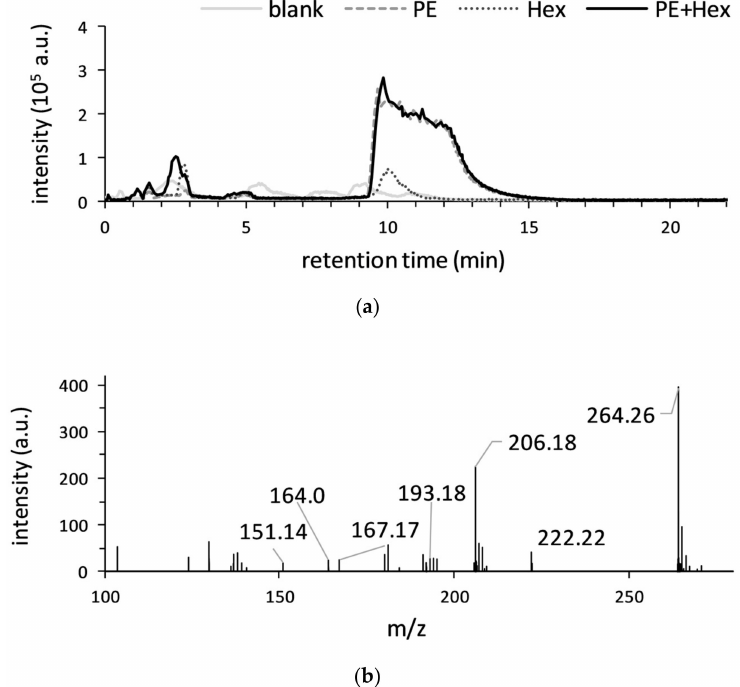
Figure 1. Tentative identification of a carbonyl-amine adduct derived from phosphatidylethanolamine (PE) (16:0 / 18:1) and hexanal. Overlaid base peak chromatograms ( m / z 50–2500) obtained from LC-ESI-QTOF-MS in positive ion mode ( a ). PE (16:0 / 18:1) (0.8 mM) and hexanal (1.6 mM) were incubated in the dark at 40 ◦ C for 21 h. LC-ESI-QTOF-MS / MS spectrum of m / z 264.26 was obtained in positive ion mode with the collision energy of 15 eV ( b ). PE: PE (16:0 / 18:1); Hex: